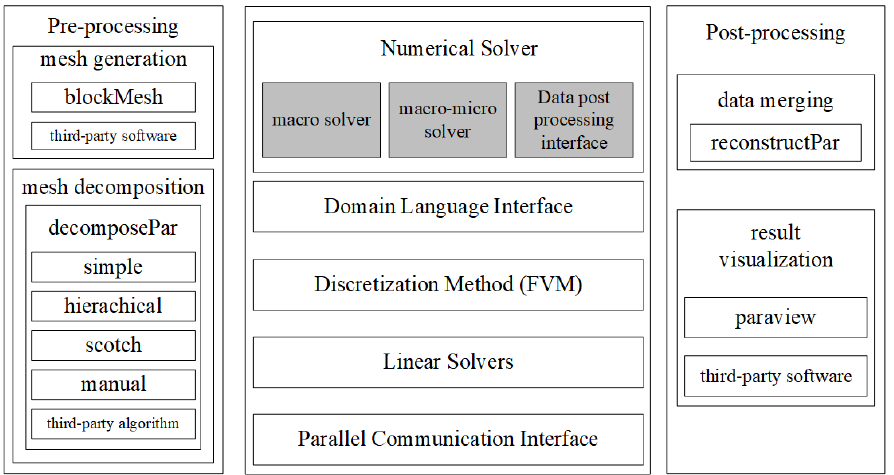
Figure 1. Numerical solver system